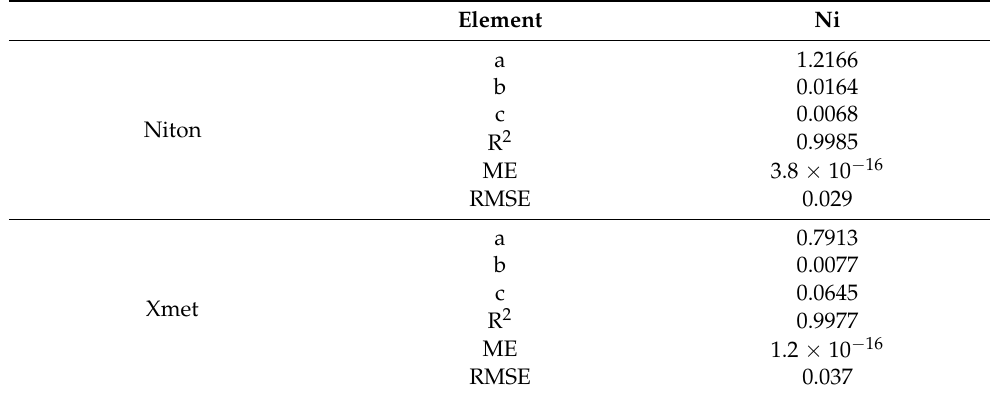
Table 4. Parameters of the multiple linear regression for the Ni and for Niton and Xmet (a: Regression coefficient for [ Ni r ] , b: Regression coefficient for [ Ni r ] × [ Fe r ] , c: y-intercept, R 2 : Coefficient of determination, ME: Mean error, RMSE: Root-mean-square